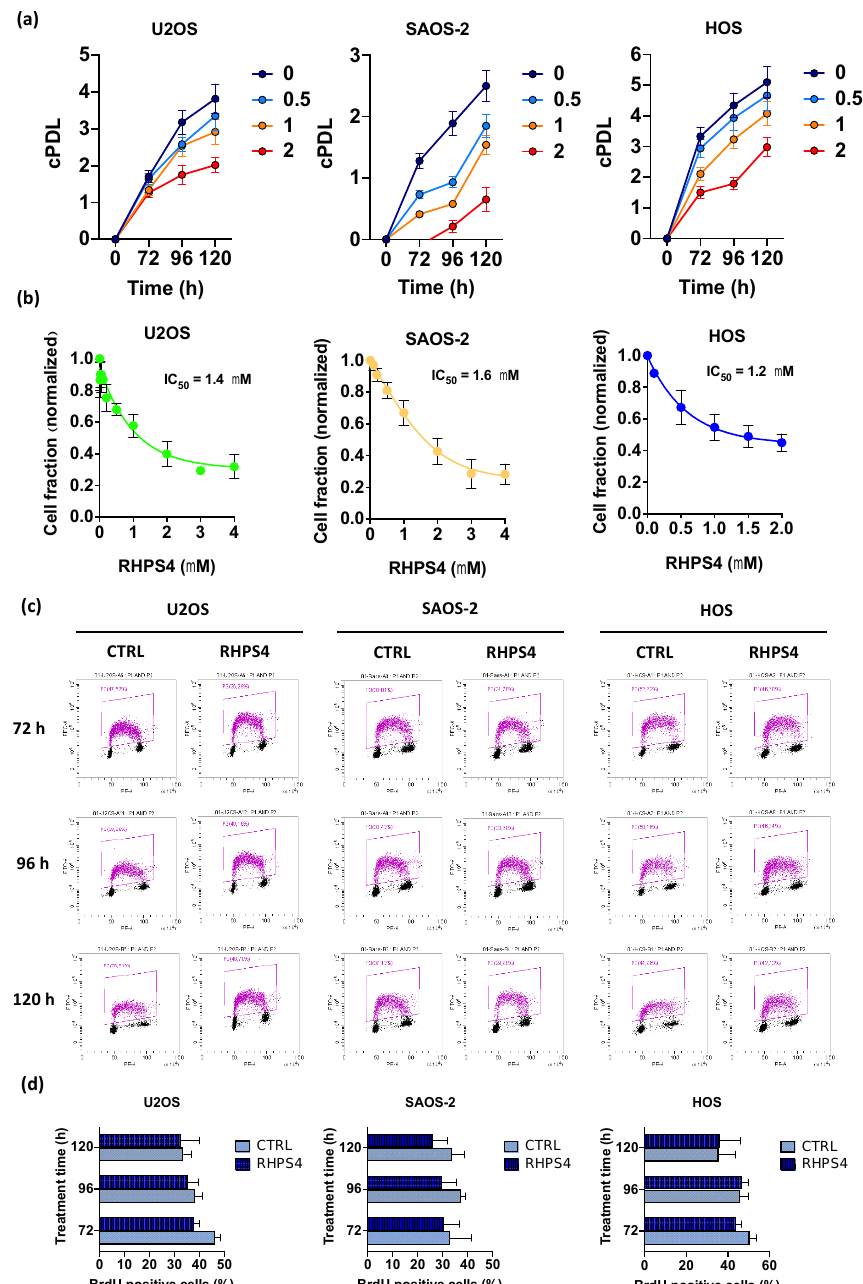
Figure 1. ( a ) Graphs show the cumulative population doubling levels (cPDL) of U2OS, SAOS-2, and HOS. Each cell line was treated with RHPS4 at different concentrations (untreated in blue, 0.5 µM in light blue, 1 µM in yellow, and 2 µM in red) and harvested at different times (72, 96, and 120 h). ( b ) Sensitivity of U2OS, SAOS-2, and HOS osteosarcoma cell lines to RHPS4 concentrations ranging from 0.01 to 4 μM, evaluated after 120 h. These data, obtained by sulforhodamine B (SRB) assay, indicate that RHPS4 sensitivity was comparable in alternative lengthening of telomeres (ALT)-positive (IC50 = 1.4 and 1.6 μM in U2OS and SAOS-2, respectively) and telomerase-positive (IC50 = 1.2 μM in HOS) osteosarcoma cell lines. ( c ) Analysis of the percentage of BrdU incorporating cells as evaluated at 72, 96, and 120 h after RHPS4 treatment. ( d ) Histogram showing the percentage of BrdU incorporating cells excluded S-phase depletion upon RHPS4 treatment at the different fixing times (72, 96, and 120 h). Errors bars denote standard deviations. * p < 0.05, ** p < 0.01, *** p < 0.001 (Student’s t -test).